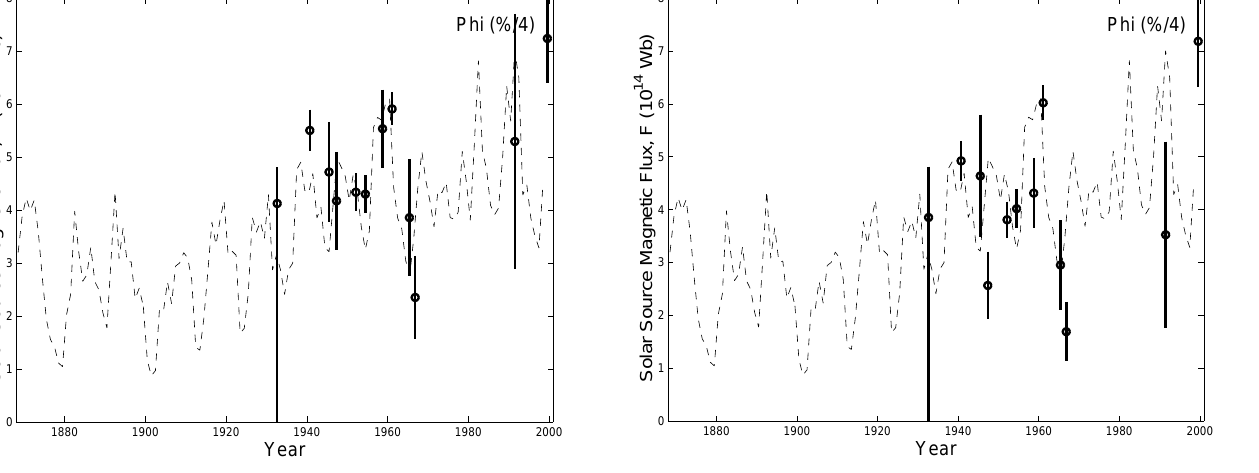
Fig. 5. The same as for Fig. 1 for 8 S , the 8 values that have been corrected to account for the variation of (r + dr)/r using the curves presented in Fig. 3. The degree to which each of these two curves is used in the correction factor is determined by the estimate f of the phase of the solar cycle during that eclipse, based on the sunspot